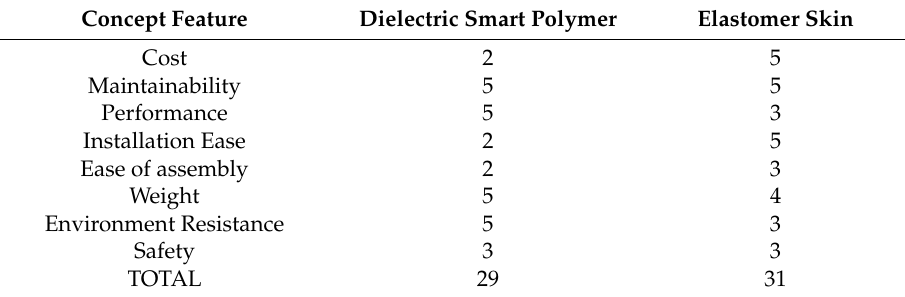
Table 1. Concept design